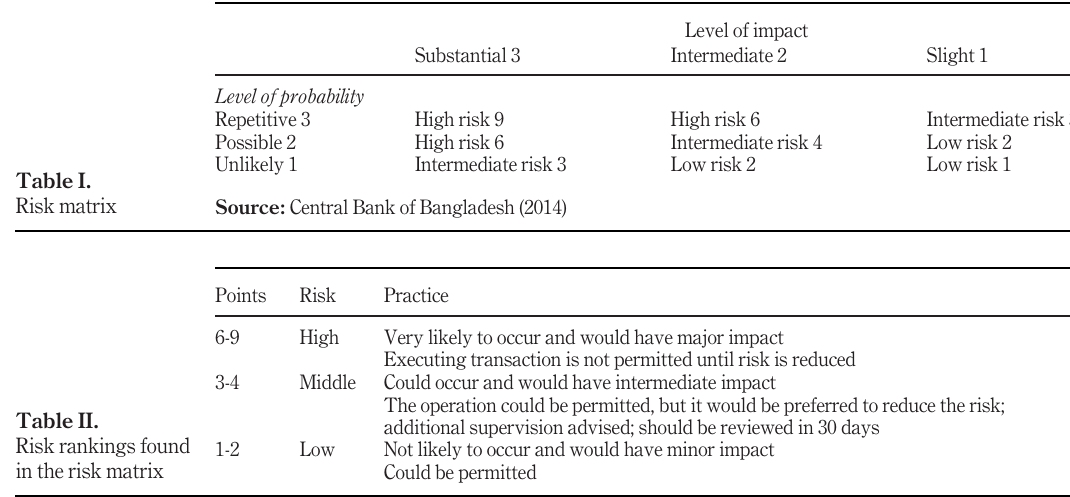
Table II. Risk rankings found in the risk matrix